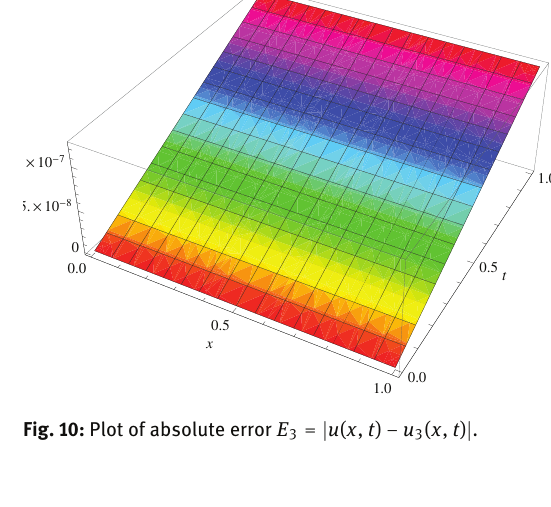
Fig. 10: Plot of absolute error E 3 = | u ( x , t ) − u 3 ( x , t ) | .